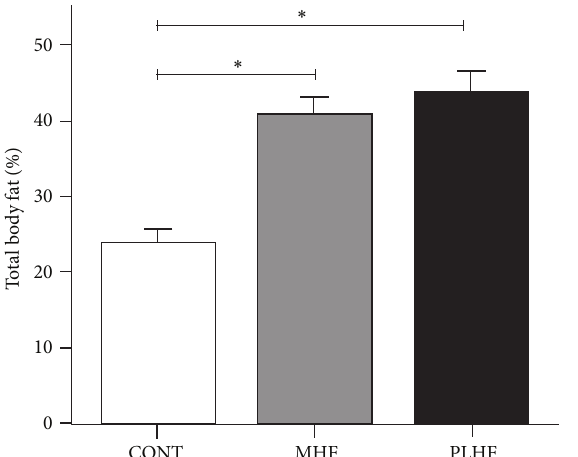
Figure 1: Total body fat mass (percent) as quantified by DEXA scan in adult CONT, MHF, and PLHF offspring. Data are means ± SEM, 𝑛 = 10–12 per group. ∗ 𝑃 < 0.05 .